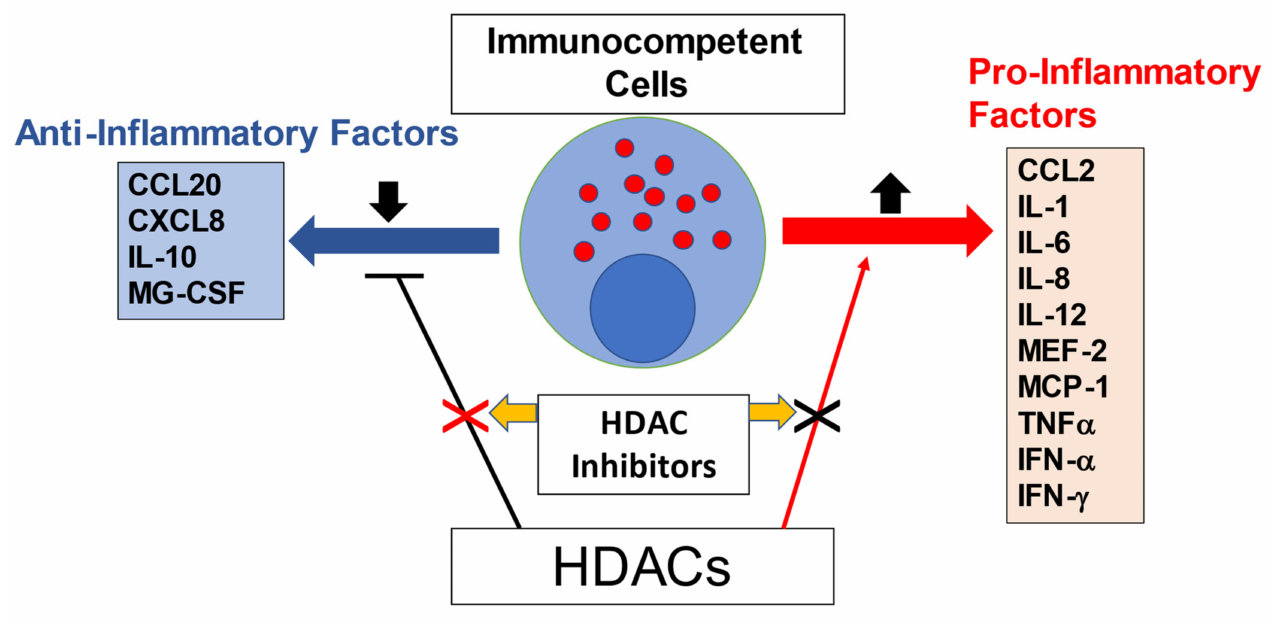
Figure 4. HDAC inhibitor as an anti-inflammatory